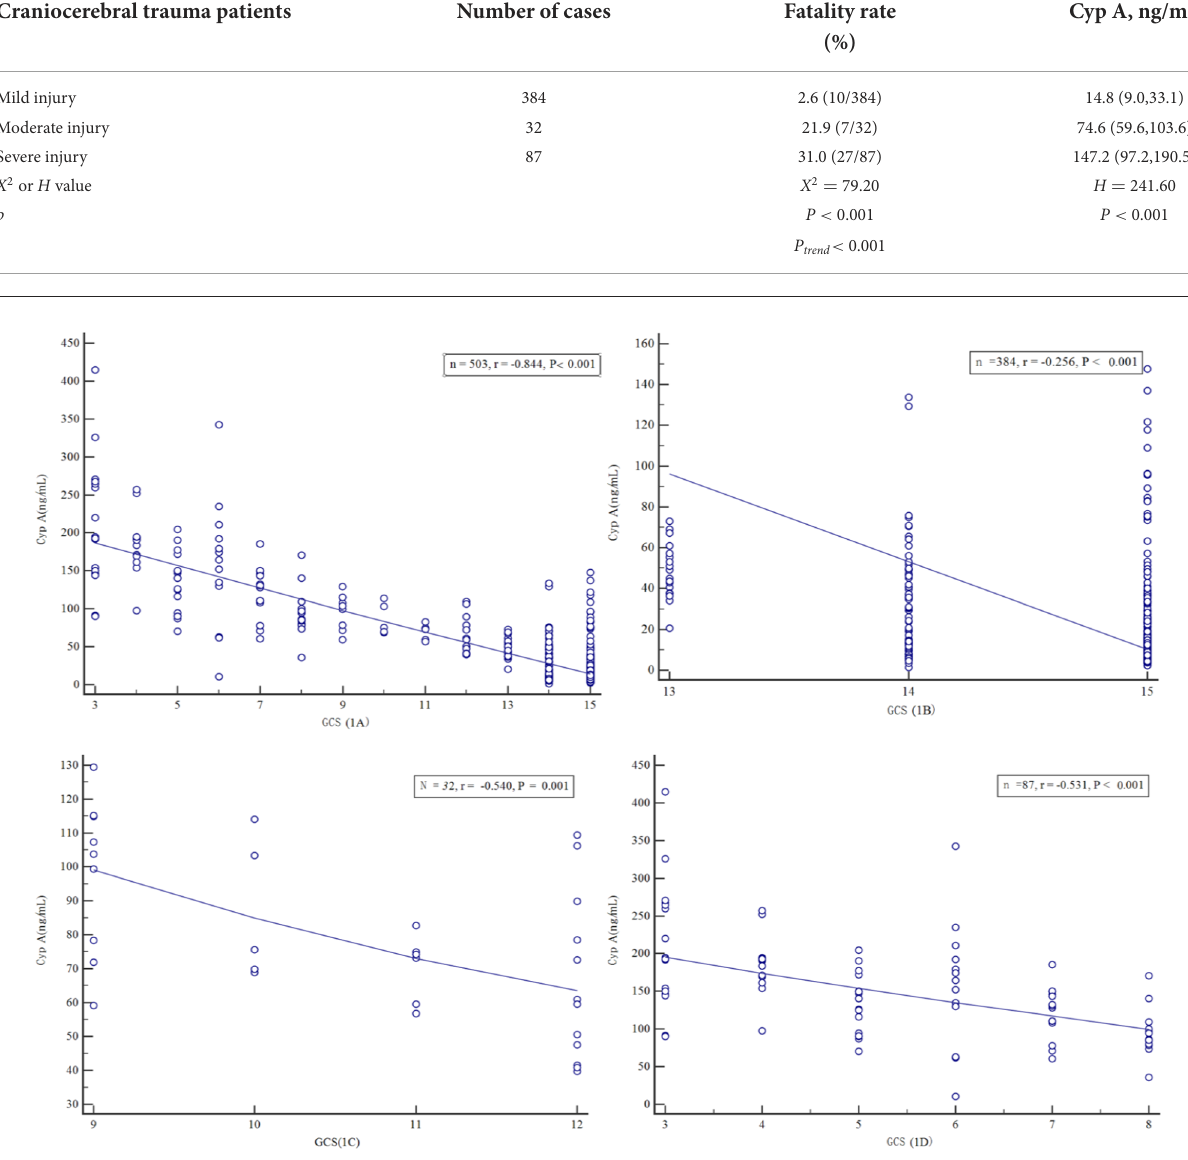
TABLE 2 Comparison of mortality and Cyp A levels in patients with different severity of craniocerebral injury. Craniocerebral trauma patients